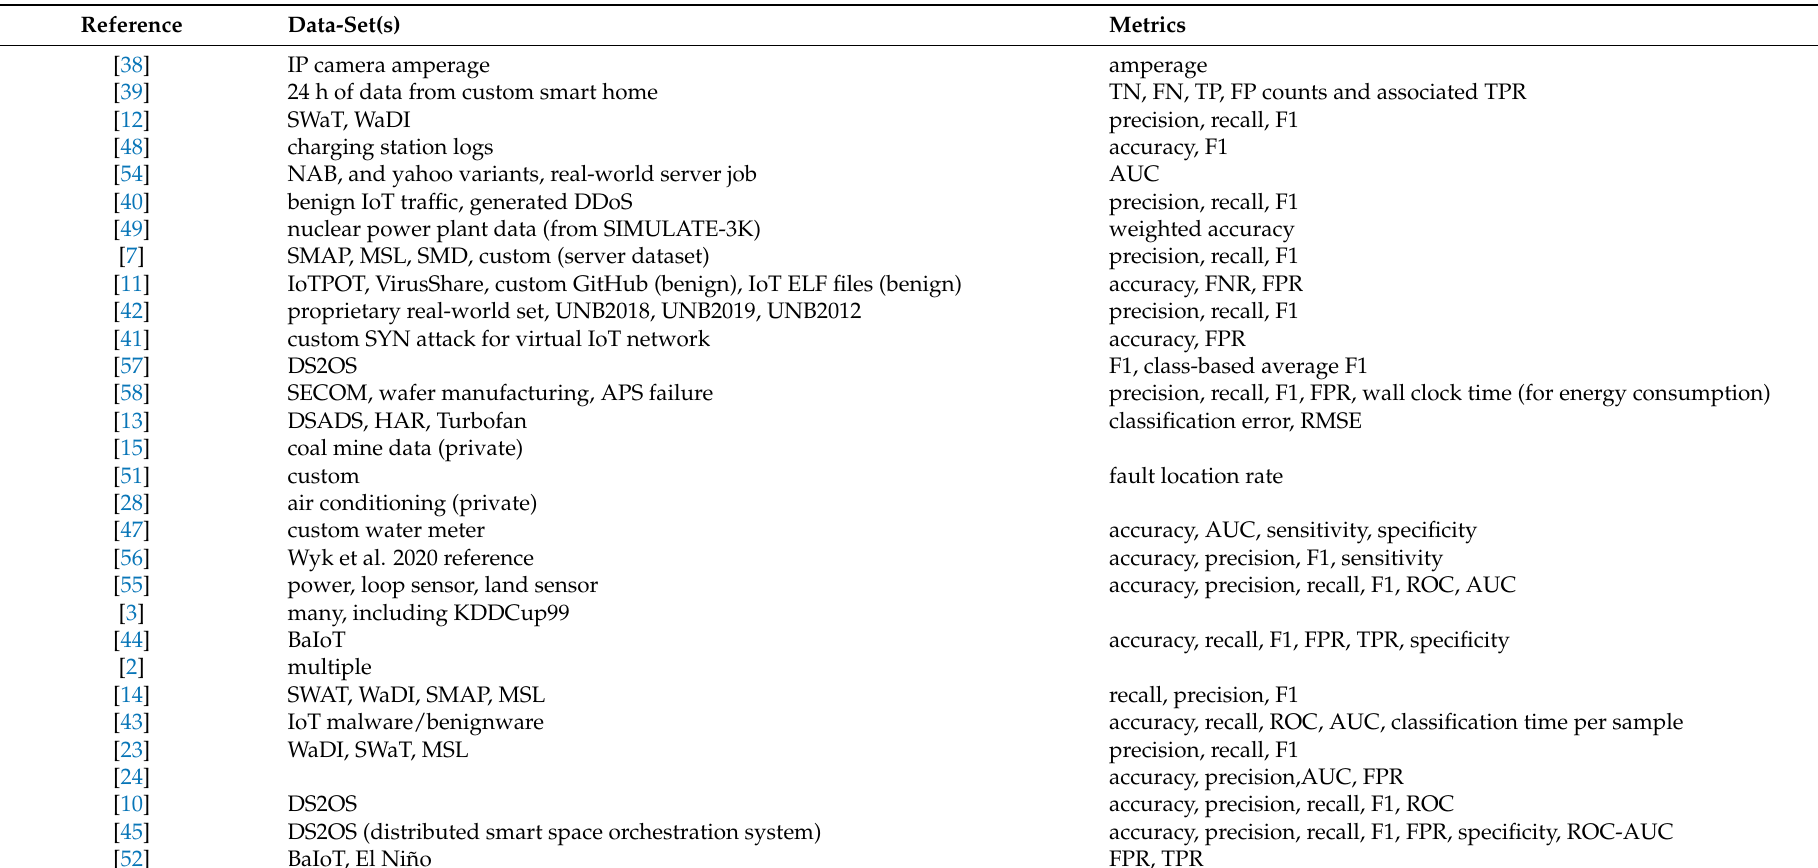
Table A3. Breakdown of data-sets and metrics used by surveyed